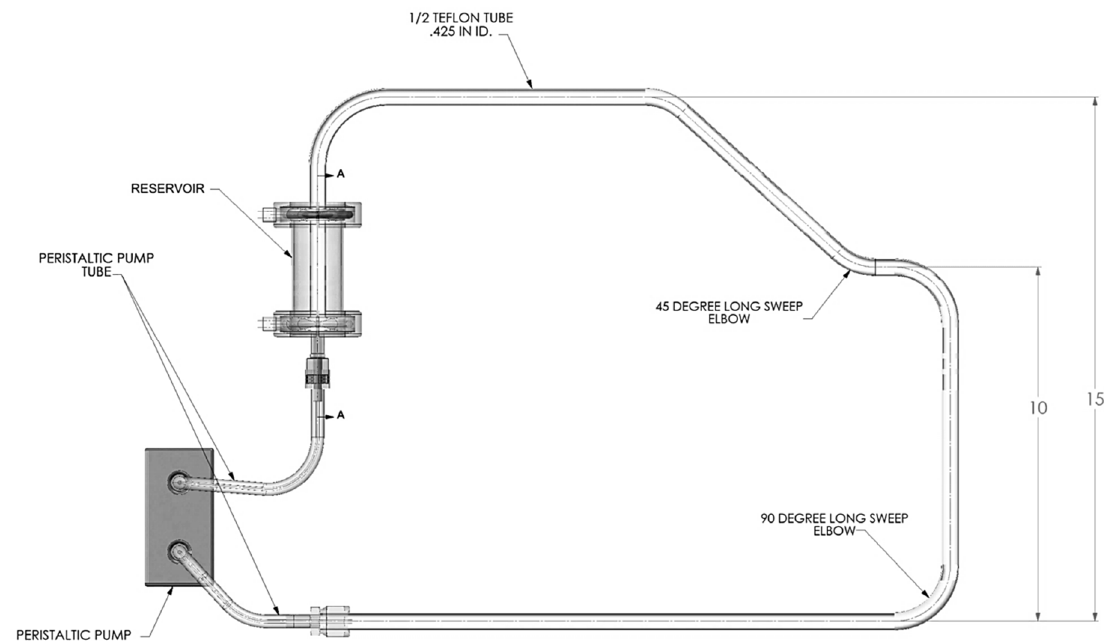
Figure 17. Ammonia borane slurry transport testing apparatus. Length scale is in inches.